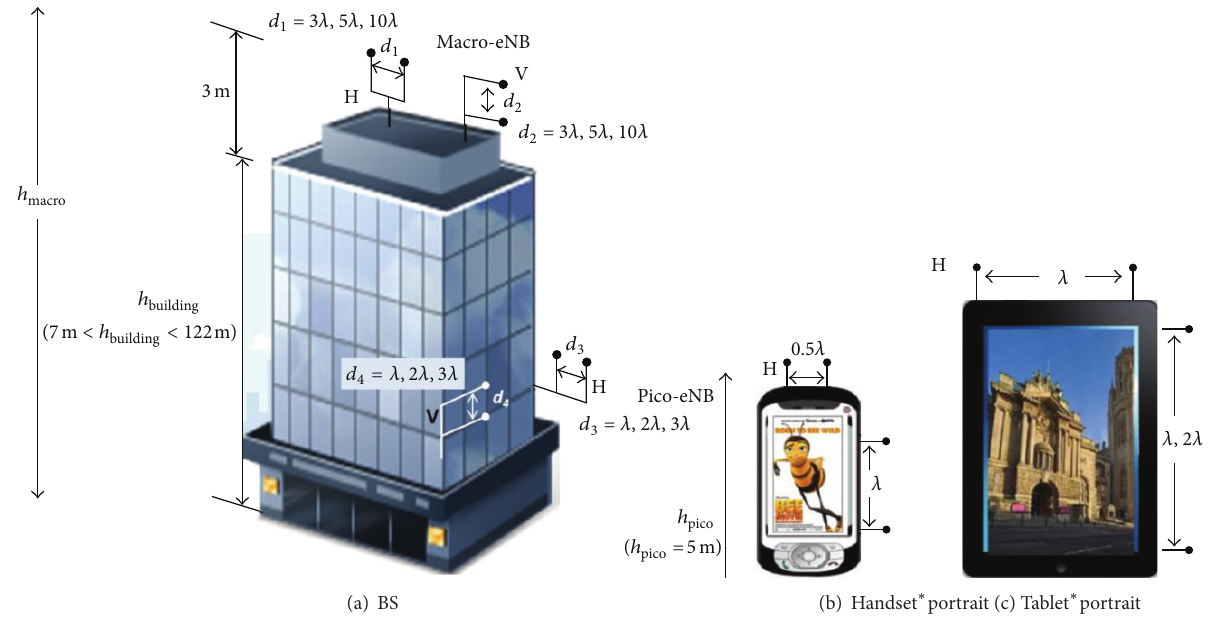
Figure 3: Illustrative view of antenna spacings and configurations at the BS and UE ( ∗ in practice the UE antennas are embedded within the handset